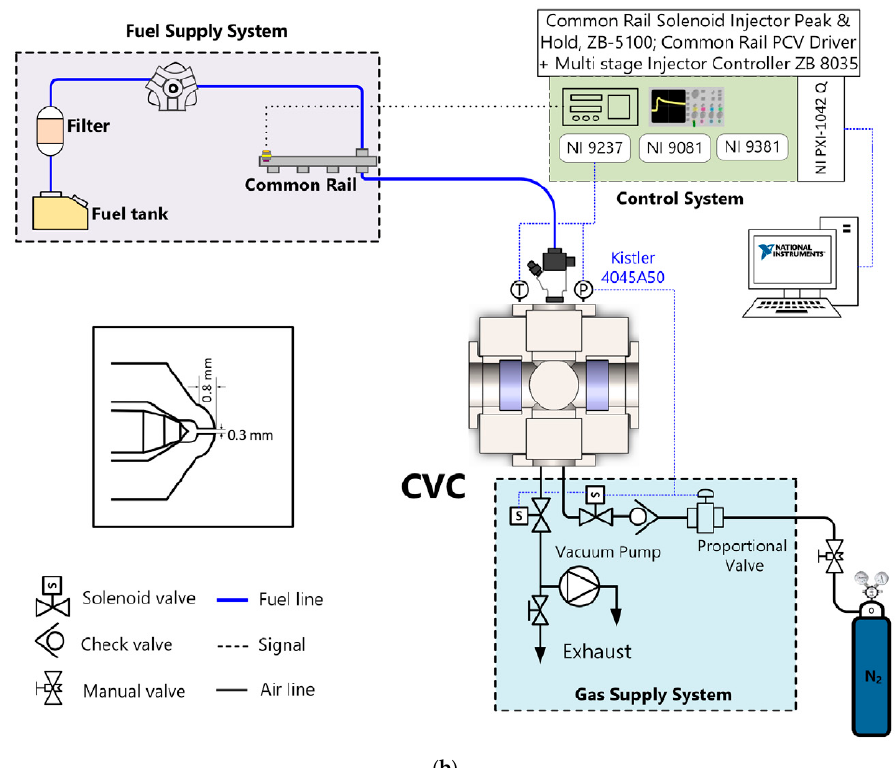
Figure 6. Experimental systems . ( a ) Pictorial representation of constant volume chamber (CVC), ( b ) Schematic diagram of the experimental system [Reprinted from Fuel Processing Technology, Vol. 178, Shubhra Kanti Das, Kihyun Kim, Ocktaeck Lim, Experimental study on non-vaporizing spray characteristics of biodiesel-blended gasoline fuel in a constant volume chamber, Copyrights (2018); with permission from Elsevier].